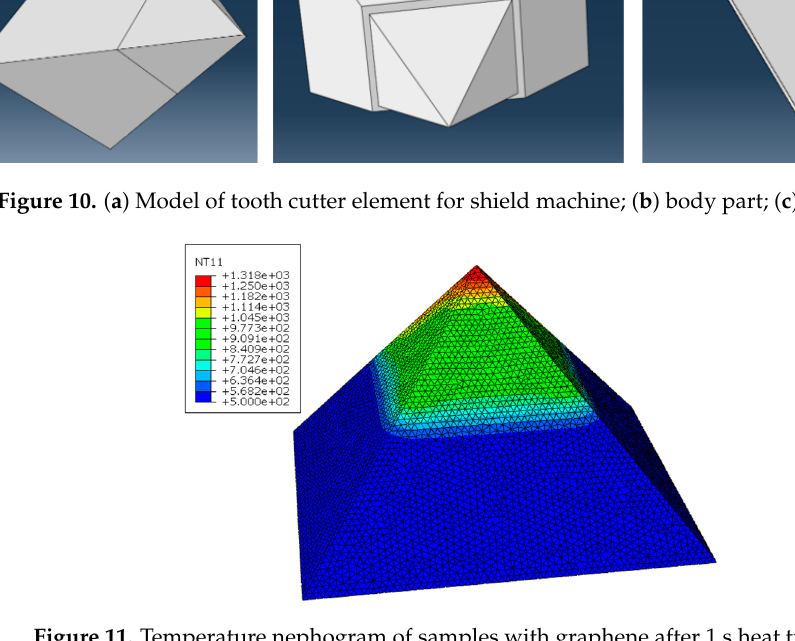
Figure 12. ( a ) Temperature variation of the A ‐ point original sample and the graphene ‐ added sample with time; ( b ) temperature difference between the A ‐ point sample and the graphene sample with time.